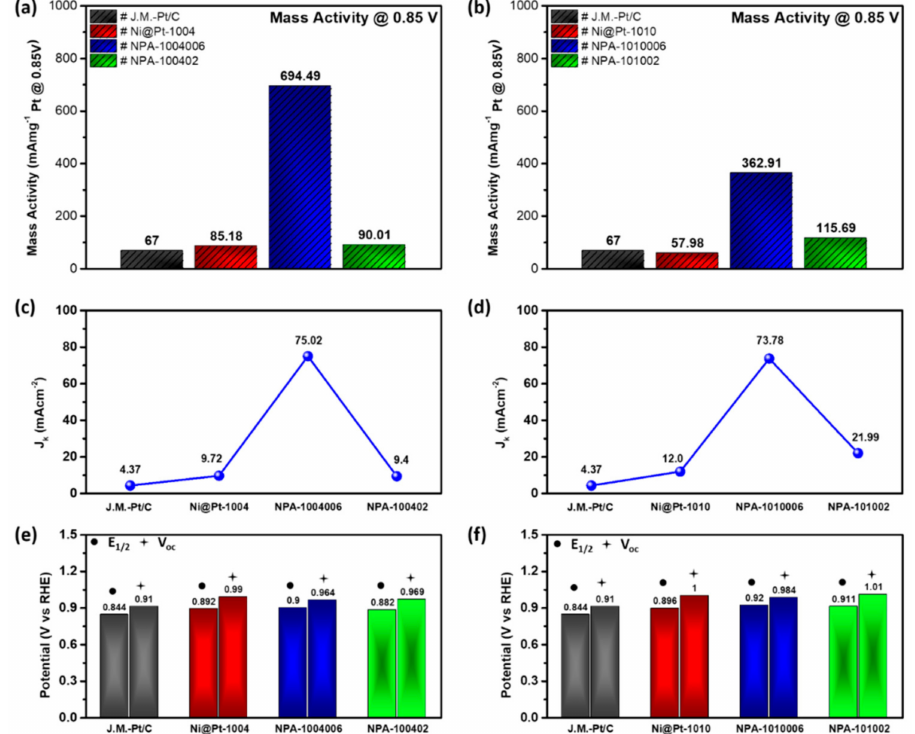
Figure 5. Electrochemical results of experimental nanocatalysts (NCs). ( a , b ) Oxygen reduction reaction (ORR) mass activity of NCs compared to the commercial Johnson Matthey-Pt / C at 0.85 V (vs. the reference hydrogen electrode (RHE)). ( c , d ) Kinetic current density of the experimental NCs and Johnson Matthey-Pt / C at 0.85 V (vs. the RHE). ( e , f ) Onset potential and half-wave potential of the experimental NCs and Johnson Matthey-Pt /